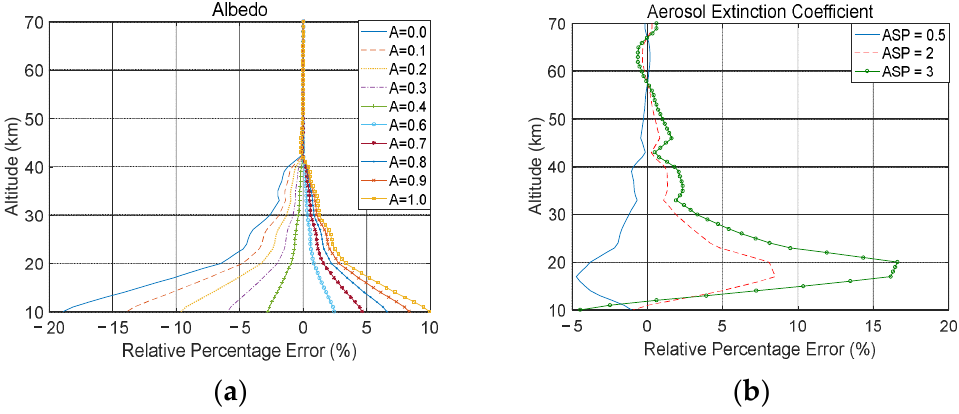
Figure 4. Relative percentage error of SCIAMACHY limb ozone profiles simulated for correct and incorrect values in parameter settings. ( a ) Albedo; ( b ) aerosol extinction profile.